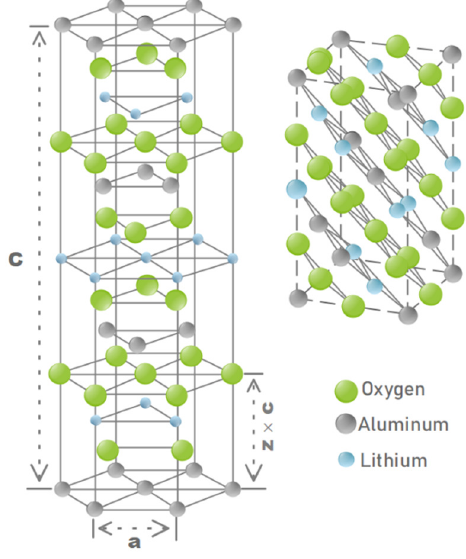
Figure 3. α-NaFeO 2 -type structure of LiAlO 2 . Figure 3. α -NaFeO 2 -type structure of LiAlO 2